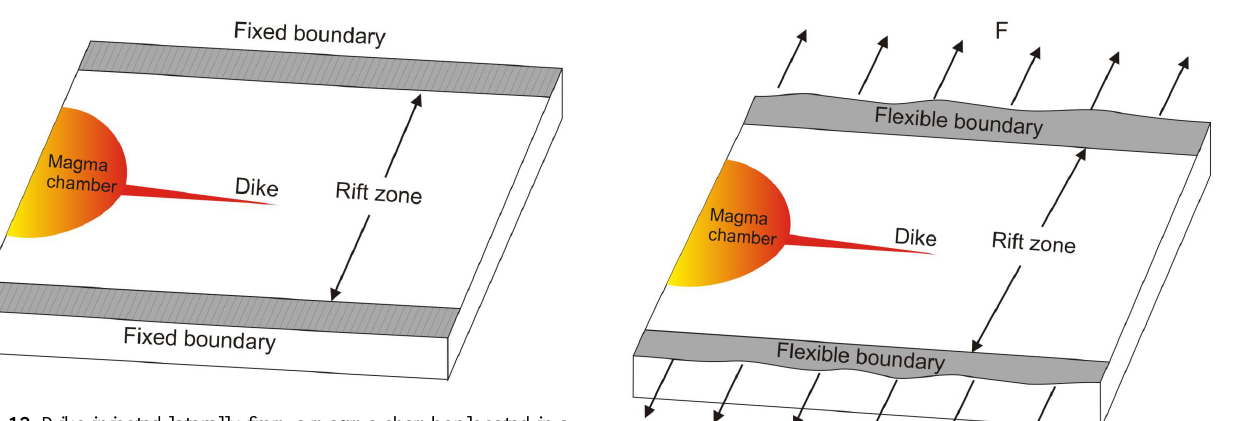
Fig. 12. Dike injected laterally from a magma chamber located in a volcanic edifice associated with a rift-zone segment. A fixed bound- ary means that the boundary displacement is constant during the dike emplacement – i.e. the boundary does not move.